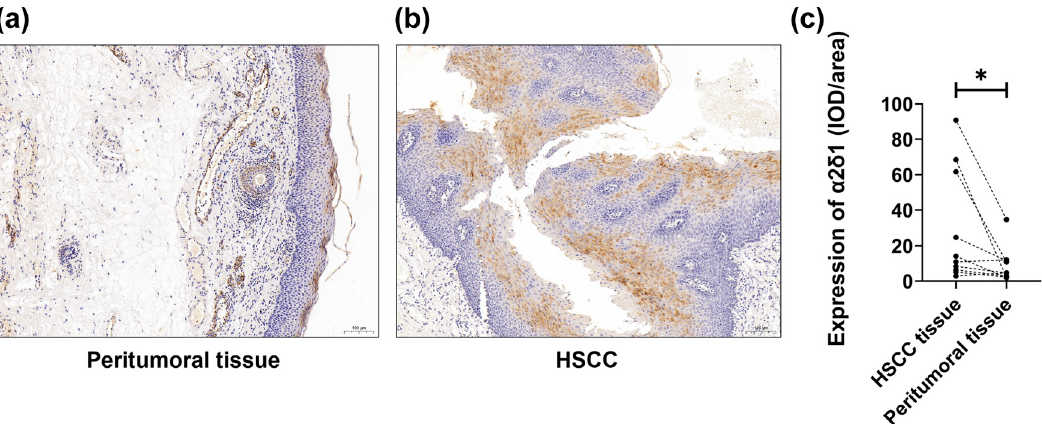
Figure 1: Expression level of α 2 δ 1 in hypopharyngeal squamous cell carcinoma ( HSCC ) and paired peritumoral mucosal tissues. Expression of α 2 δ 1 in ( a ) paired peritumoral tissue ( 100 ×) and ( b ) HSCC tissue ( 100 ×) . ( c ) Expression level of α 2 δ 1 was signi fi cantly increased in paired peritumoral tissue than those in HSCC tissues ( n = 10, P = 0.0359 )